Question: Which kind of chart has been used to present this data?
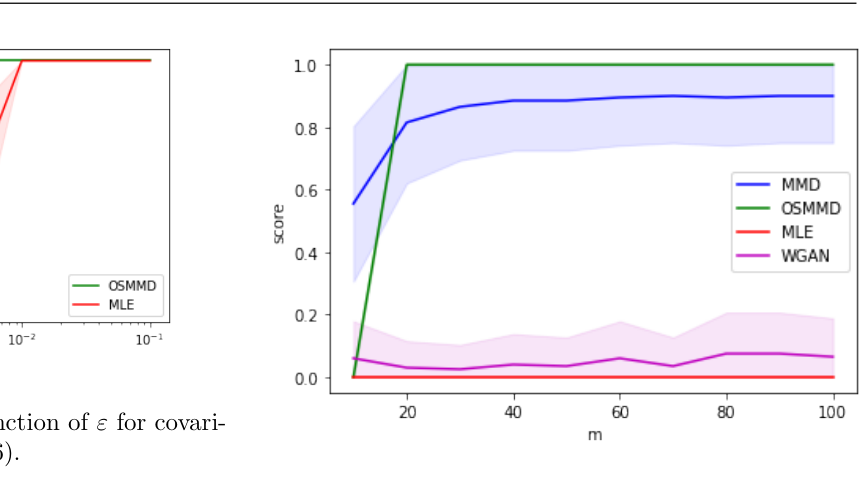
Answer: line